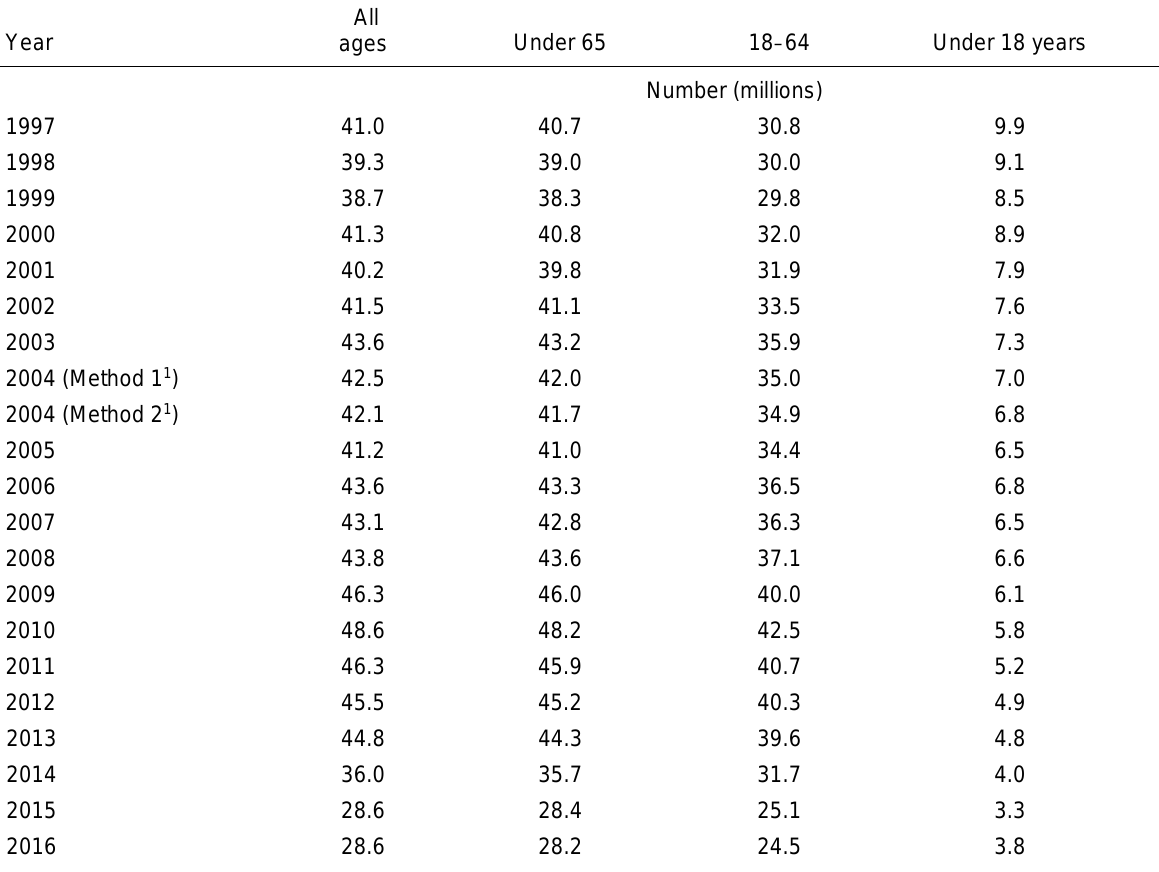
Table 1.1a. Number of persons without health insurance coverage at the time of interview, by age group: United States,